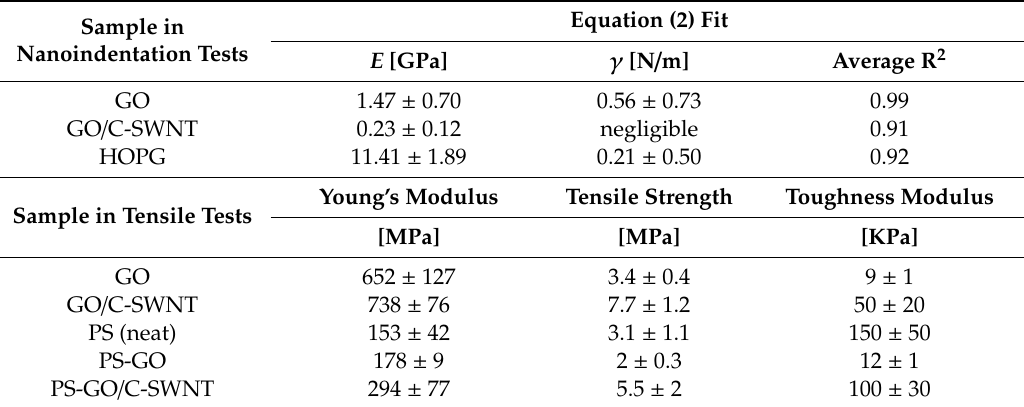
Table 1. Nanoindentation and tensile tests of GO, GO / C-SWNT and PS composites. Sample